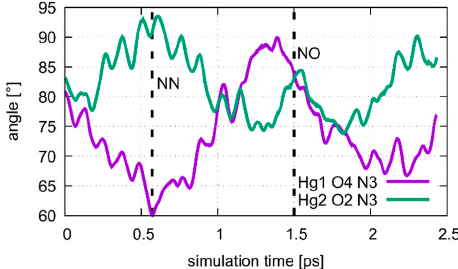
Figure 14. Dynamics of the Hg1 ··· T 7O4 ··· T 7N3 and Hg2 ··· T 7O2 ··· T 7N3 angles during the oscillation